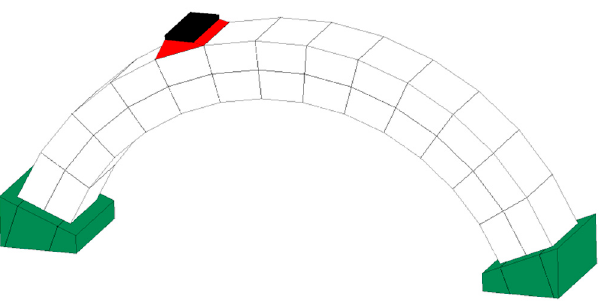
Figure 5. Discrete elements of the surface meshed geometries (with two blocks along the radial thickness).